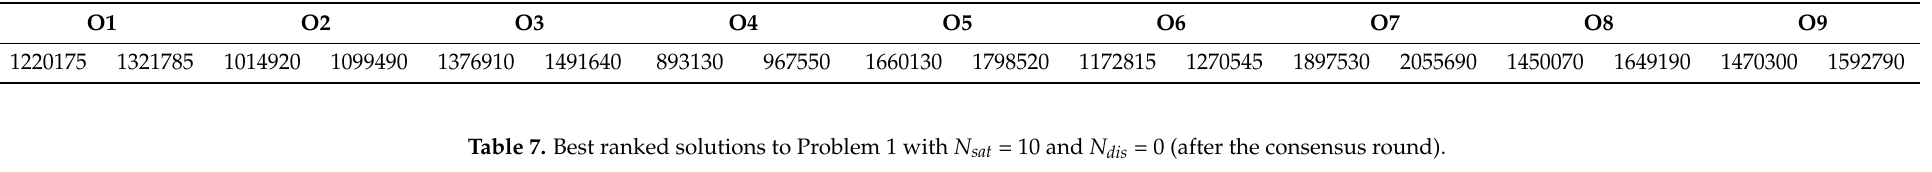
Table 6. Best consensus solution to Problem 1 with N sat = 6 and N dis = 0.